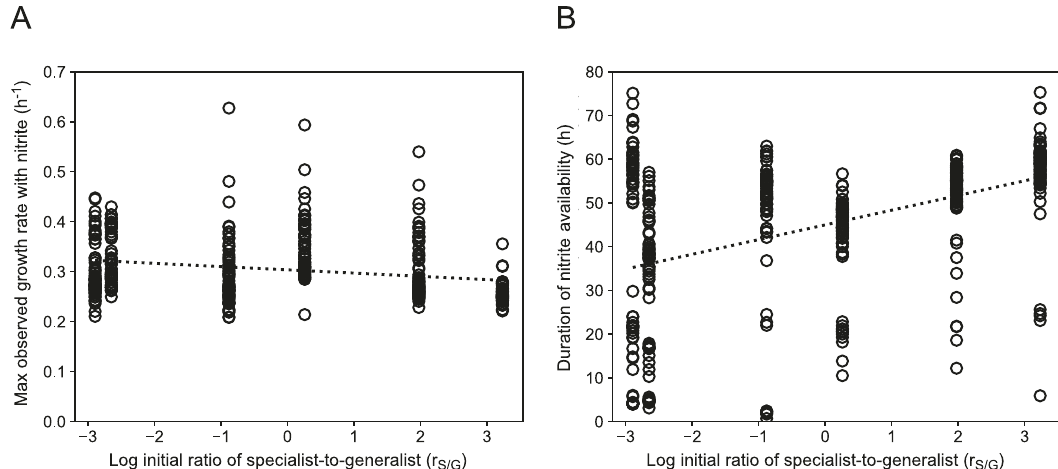
Fig. 5 Growth properties of individual isolated generalists after 12 serial batch transfers of co-cultures at pH 6.5 (strong nitrite toxicity). We mixed the generalist and specialist together at different initial r S/G s and grew them at pH 6.5 under anoxic conditions with nitrate as the growth-limiting substrate. After 12 serial transfers, we isolated individual generalists and measured ( A ) the maximum growth rate with nitrite and ( B ) the duration of nitrite availability for each isolate. Data points are measurements for individual isolates. The dashed lines are linear regression models fi t to the means for each initial r S/G